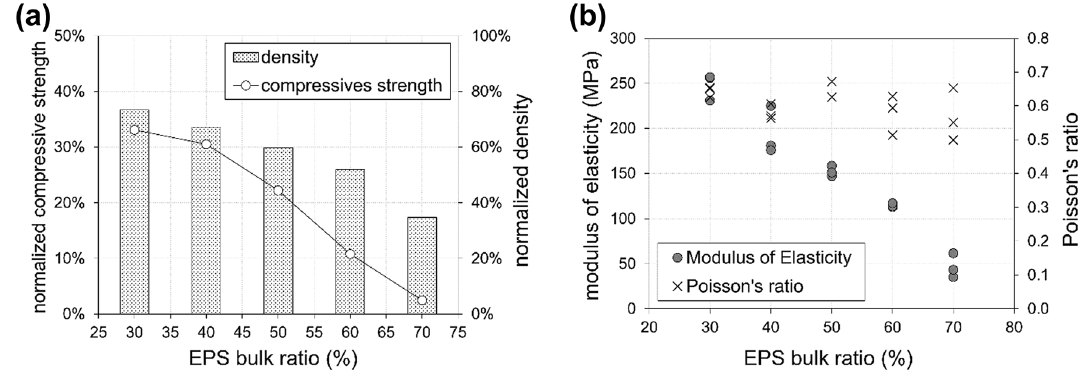
Fig. 3 Test results of HPEPC specimens depending on EPS bulk ratio; a normalized compressive strength and normalized density and b modulus of elasticity and Poisson’s ratio.